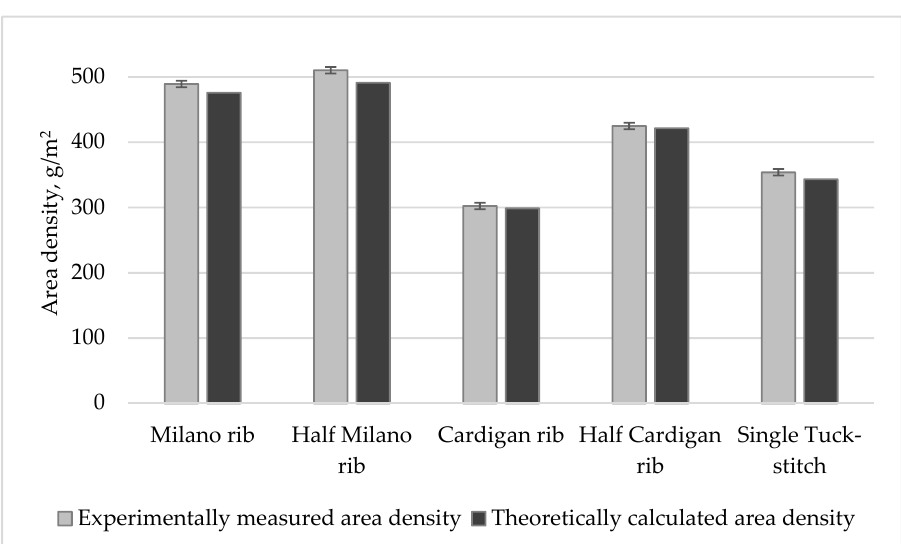
Figure 5. Comparison of theoretically calculated and experimentally measured area densities.